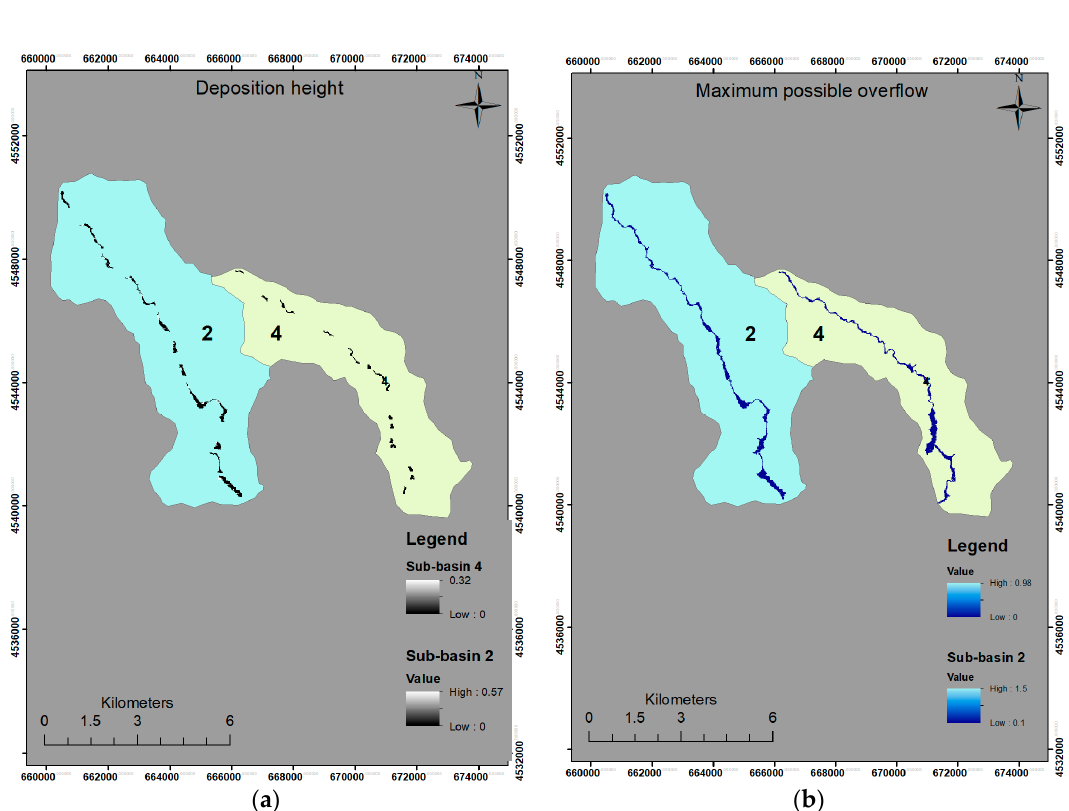
Figure 5. ( a ) Maximum possible overflow (left), ( b ) amount of sediment deposition